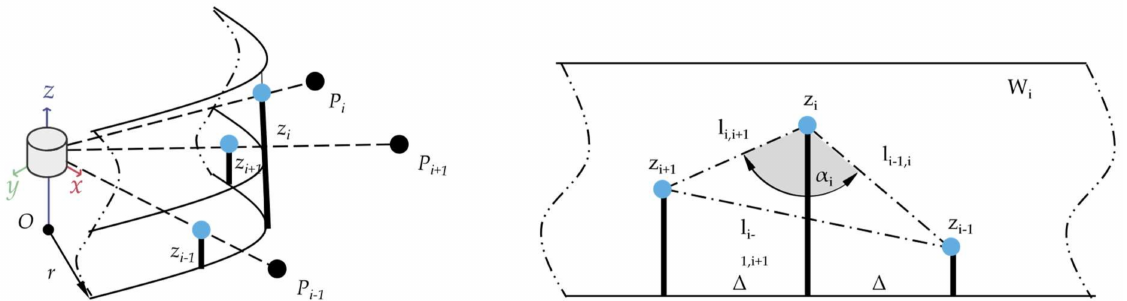
Figure 7. X-zero method, visualization of voxel